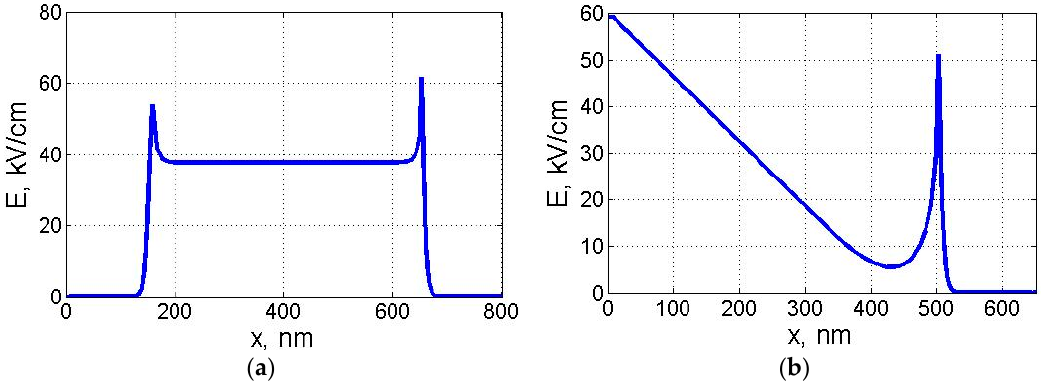
Figure 11. The coordinate distributions of electric field intensity modulus in the GaAs p-i-n structure ( a ) and Schottky-barrier photodiode with the n-type near-contact region ( b ) at the active region length of 500 nm.